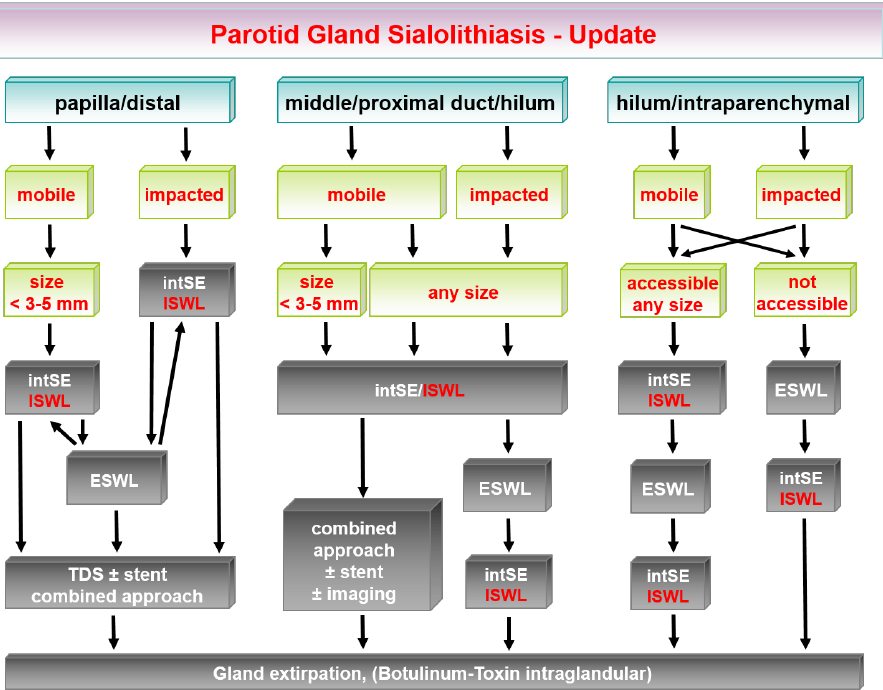
Figure 4. Parotid gland sialolithiasis: current/updated treatment algorithms. ESWL, extracorporeal shock-wave lithotripsy; intSE, interventional sialendoscopy; ISWL, intraductal shock-wave lithotripsy; TDS, transoral duct